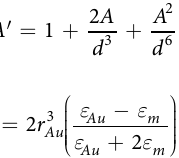
where ε Au is the dielectric function of gold and ε m is the dielectric constant of the medium. Using the values of the dielectric functions of gold determined for the calculation of the extinction spectrum of GNPs (Supporting Information, section S1) at the excitation wavelength of 480 nm, considering ε m = 1.99 (the dielectric constant of a mixture of silica, n = 1.46, and ethanol, n = 1.36), and the GNPs radius r Au = 7.5 nm, we calculated A = (9.9 nm) 3 .